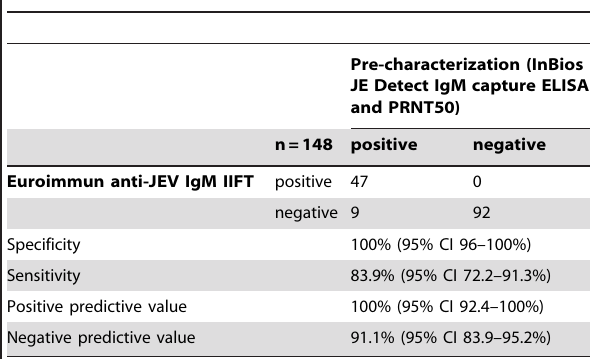
Table 3. Calculated specificity, sensitivity, positive and negative predictive values for the anti-JEV IgM IIFT in comparison to the InBios JE Detect IgM capture ELISA and